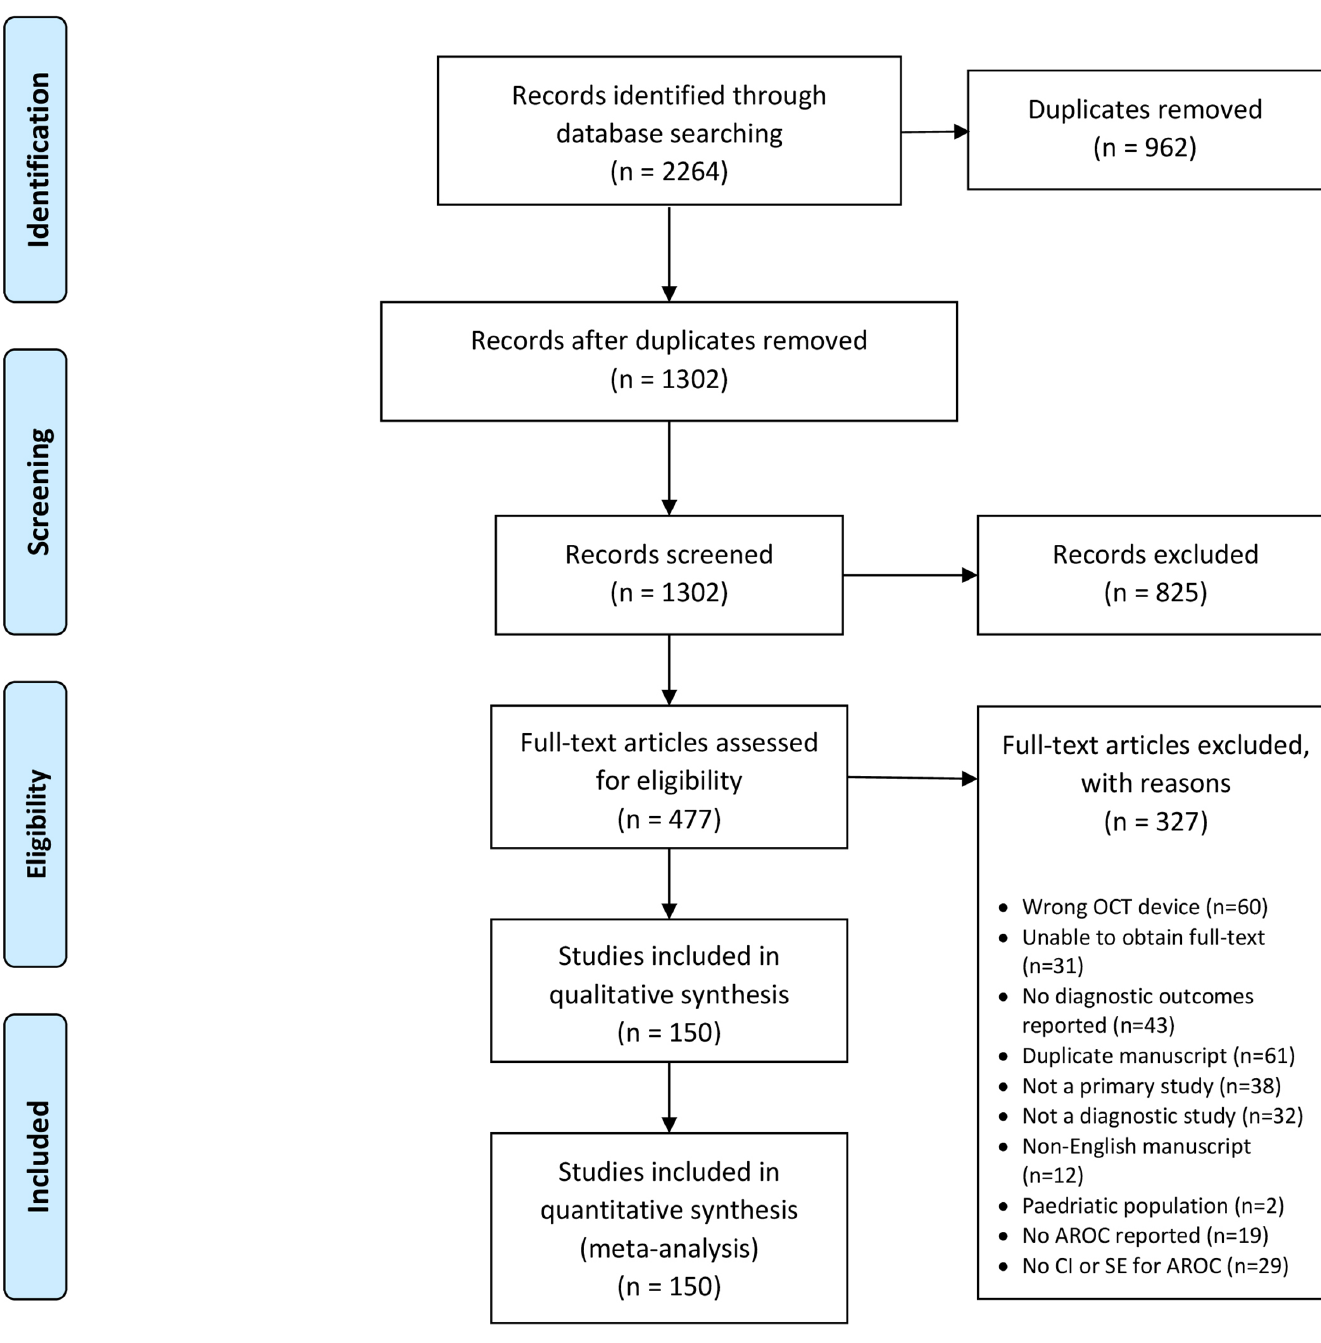
Fig 1. Study flow in this meta-analysis (PRISMA